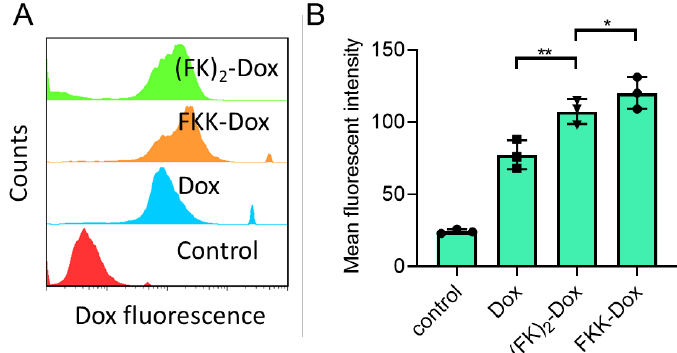
Figure 5. ( A ) Representative cellular uptake histograms obtained from cytometry analysis. Hela cells were treated with DMSO, Dox (1 µM), (FK) 2 -Dox (1 µM of Dox) and FKK-Dox (1 µM of Dox) for 4 h at 3 °C. ( B ) Quantitative analysis of cellular fluorescence of a Hela cell treated by different Dox species corresponding to Figure 5A. The values represent the average geometric mean of uptake for three independent experiments. P values were determined by the Student’s t-test. ** P < 0.01; * P < 0.05. Error bars are SD.